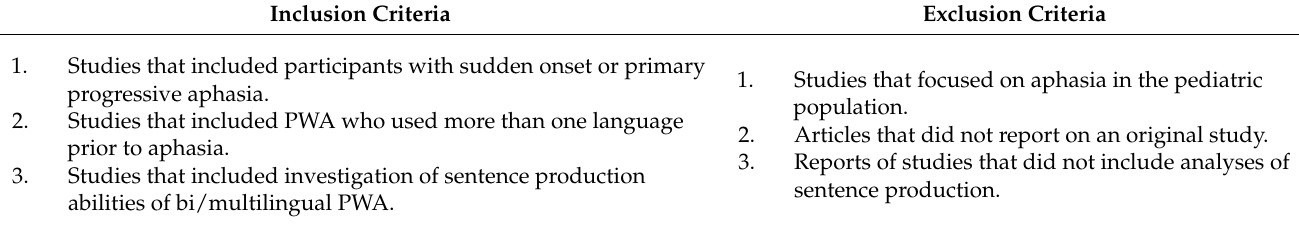
Table 2. Inclusion and exclusion criteria for articles